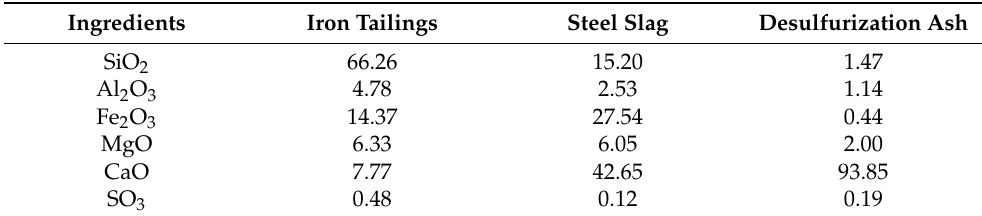
Table 1. Chemical composition of raw materials/%.